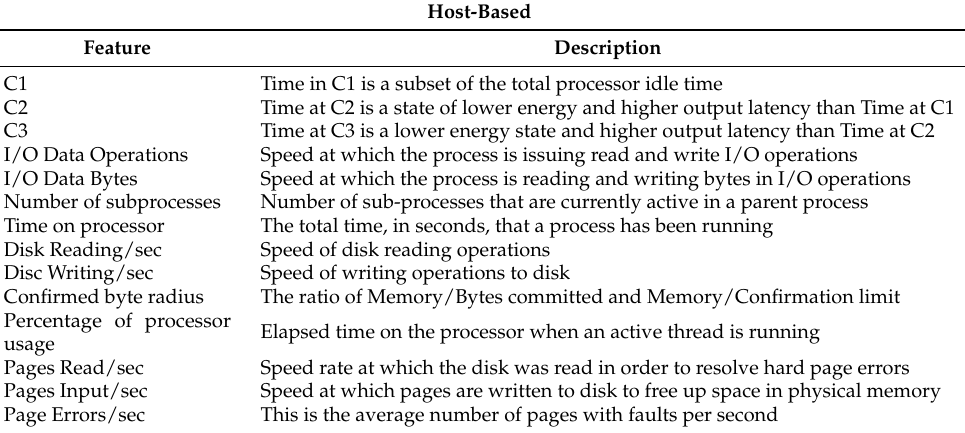
Table 1. Host-based and Network-based